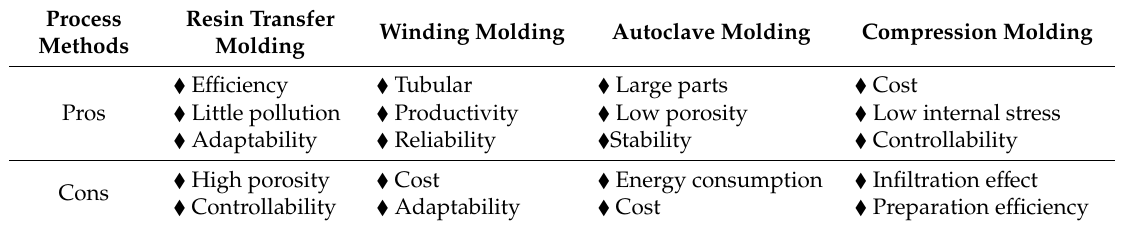
Table 1. Pros and cons of traditional carbon-fiber-reinforced polymer composite (CFRP) preparation process